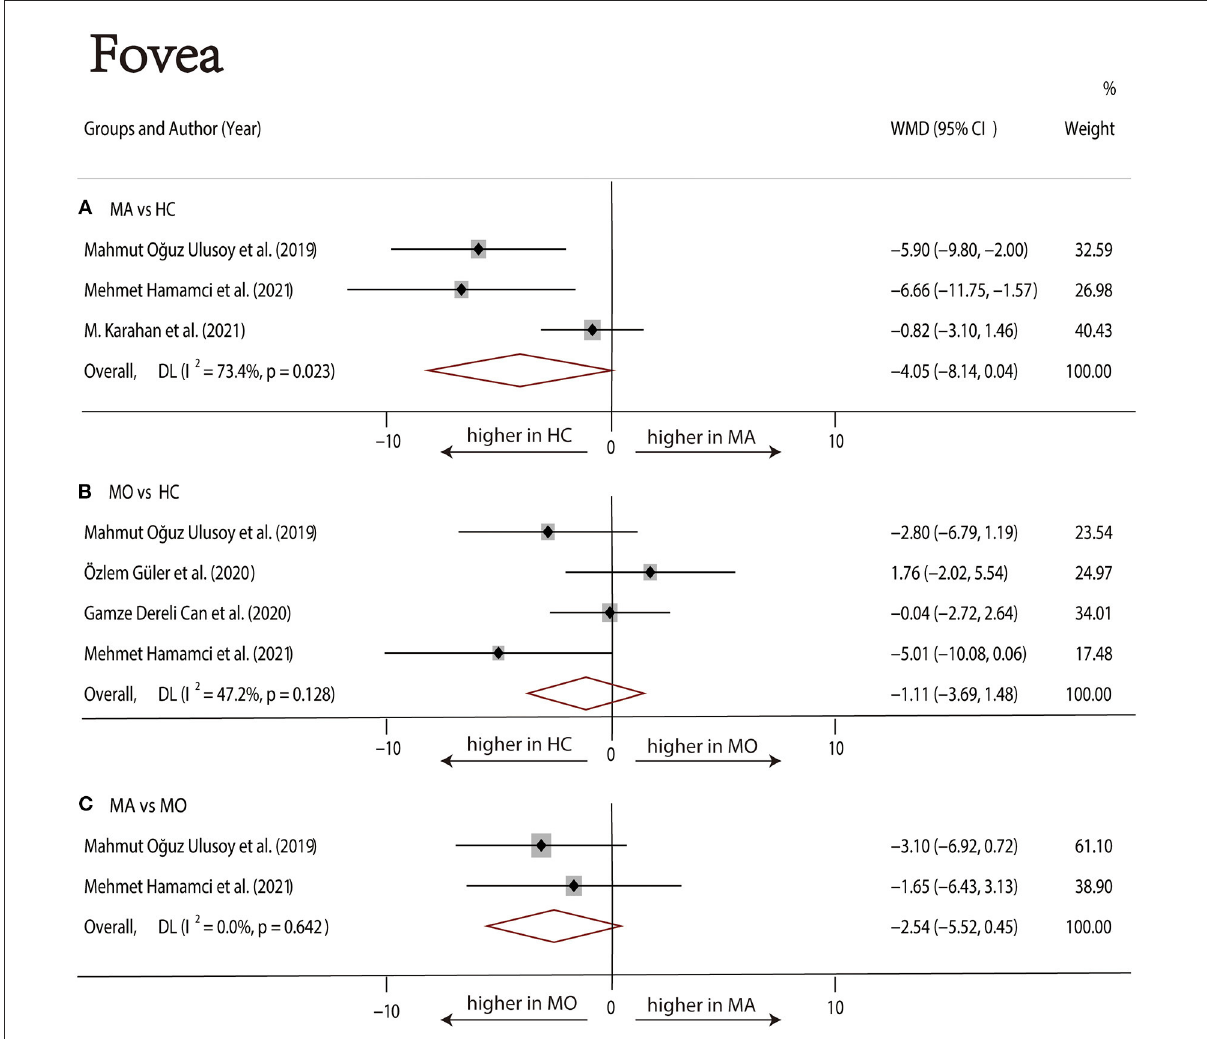
FIGURE7 Forest plot of WMD of the foveal DCP VD. (A) Foveal VD comparison of MA and HC; (B) foveal VD comparison of MO and HC; (C) foveal VD comparison of MA and MO.